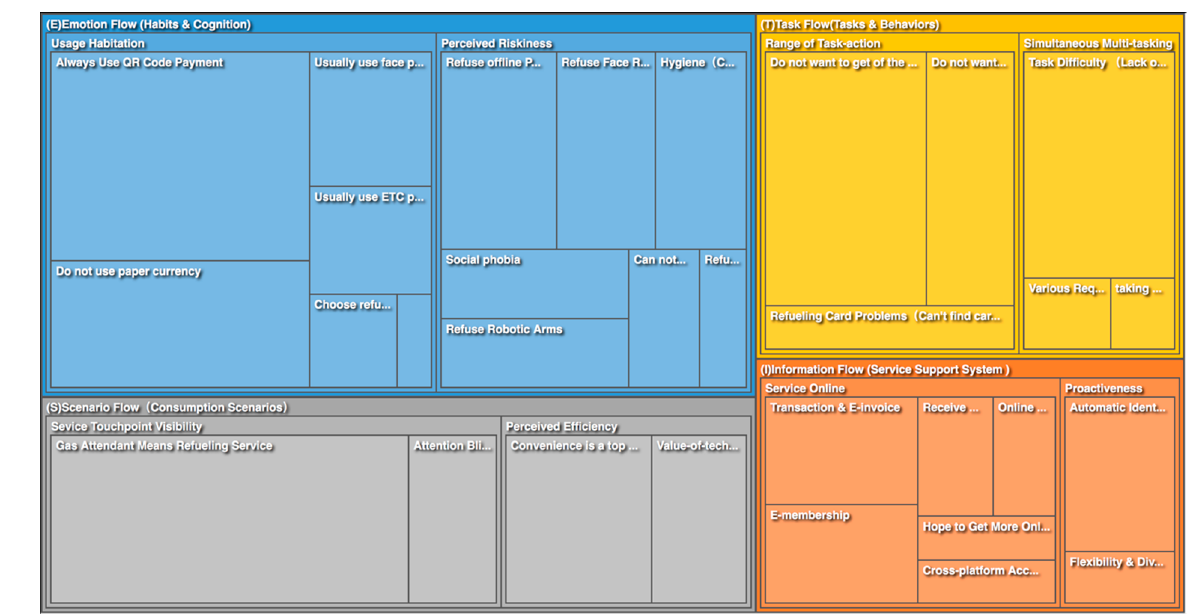
Figure 3. Hierarchical chart generated by NVivo: Nodes compared by the number of coding references.